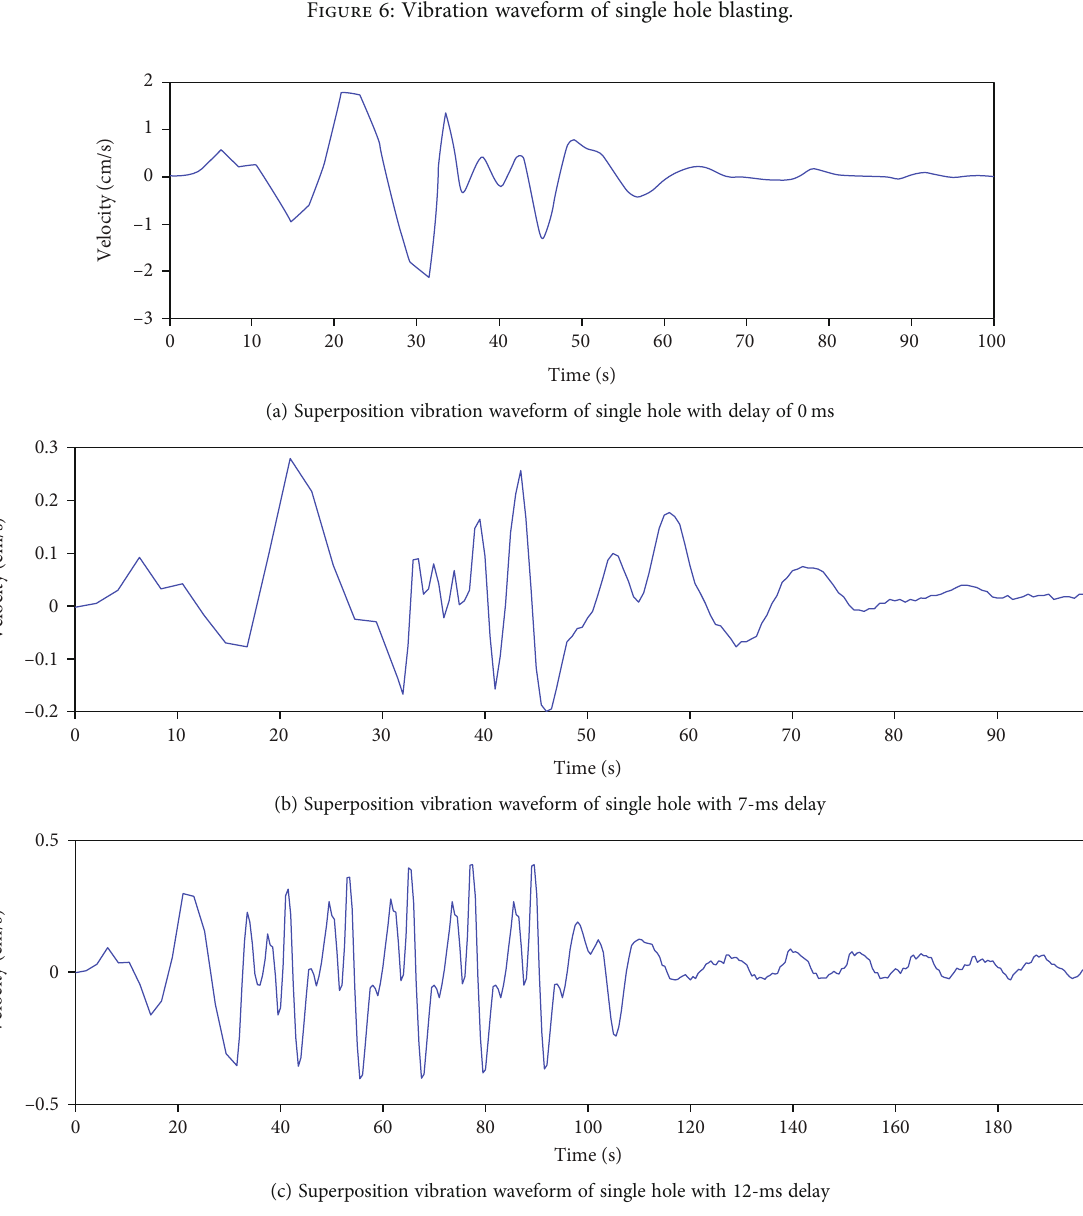
Figure 7: Superposition vibration waveform under di ff erent delay